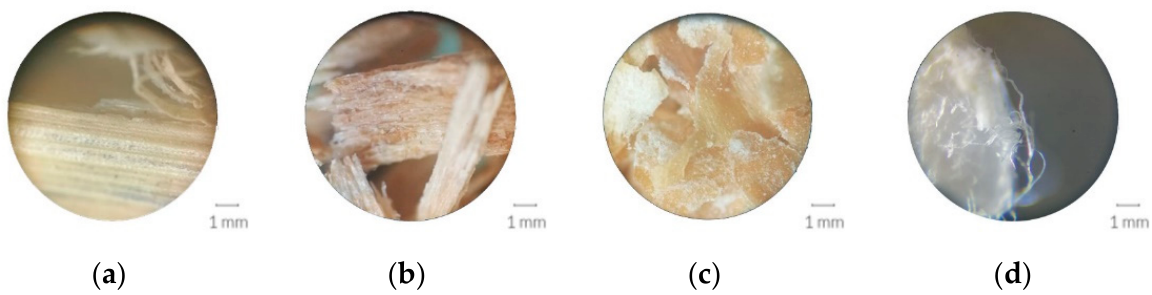
Figure 2. Substrate scale: ( a ) straw; ( b ) wood chips; ( c ) wheat bran; ( d ) bleached cellulose pulp.